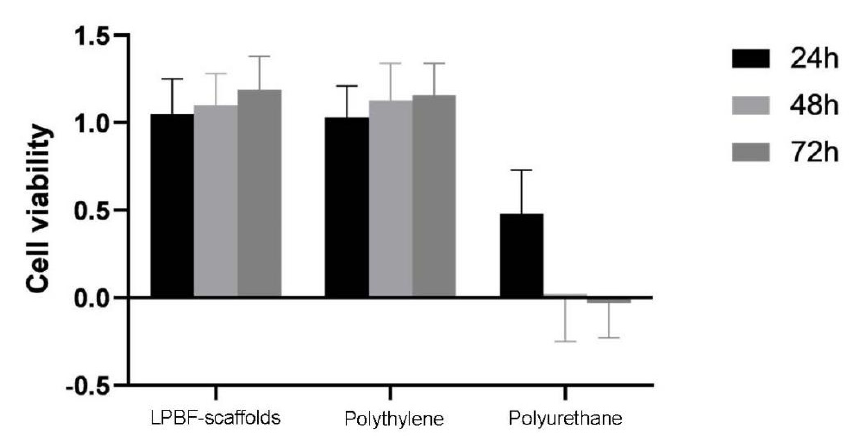
Figure 9. Cytotoxic experiments indicating cellular viability of HUVECs treated with liquid extracts of the LPBF-manufactured scaffolds, polyethylene, and polyurethane at 24, 48, and 72 h. The viabilities of the LPBF-manufactured scaffolds and polyethylene group were higher than 95%, and that of polyurethane was lower than